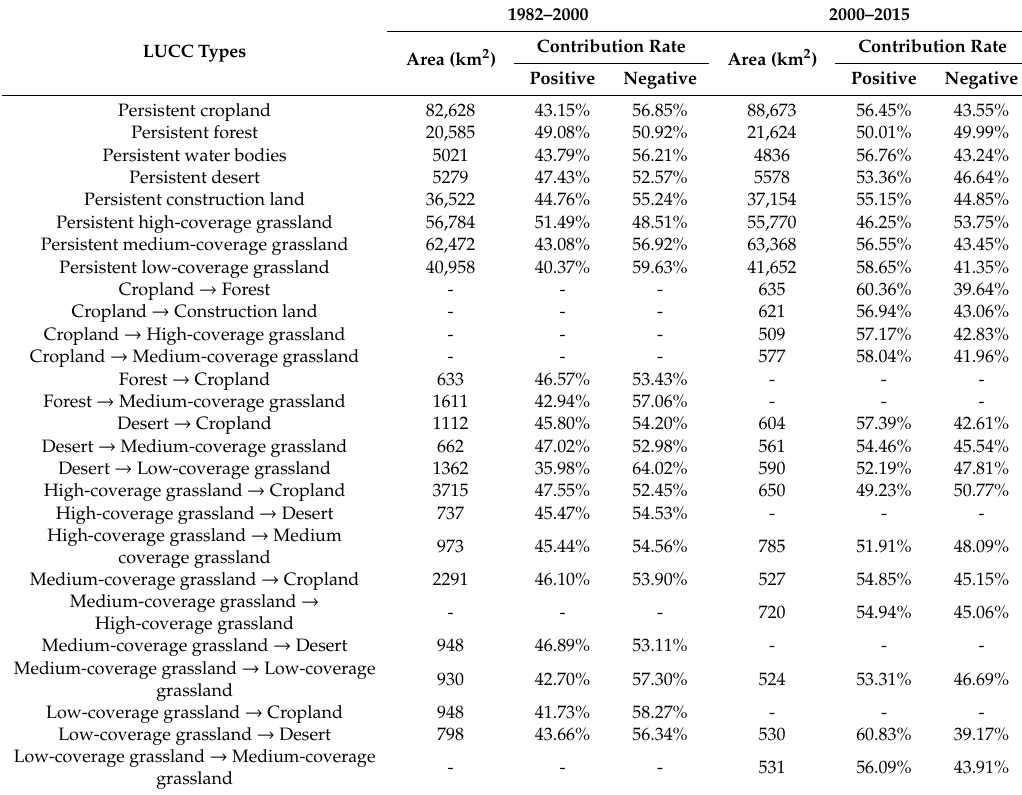
Table 1. Relative contribution rates of anthropogenic activities to the normalized di ff erence vegetation index (NDVI) in the agropastoral ecotone in northern China (APENC) during the two